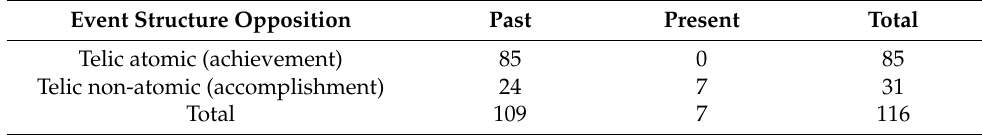
Table 8. Temporal anchoring of telic atomic vs. telic non-atomic utterances in all temporal contexts. Event Structure Opposition Past Present